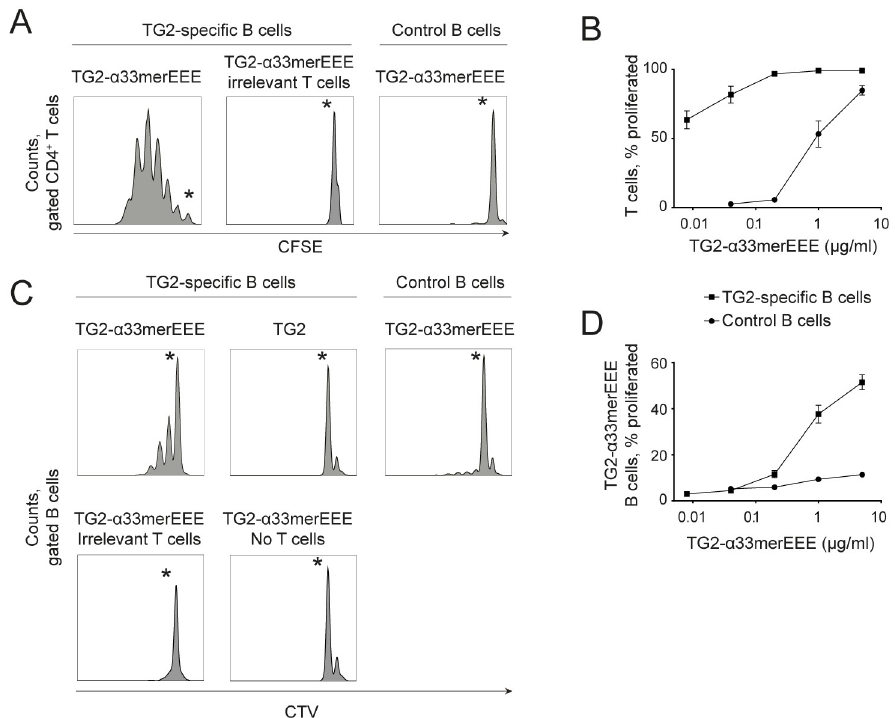
Fig 1. TG2-specific B cells and gluten-specific CD4 + T cells interact in vitro. B cells isolated from Tgm2 -/- DQ2.5.14E06 or HLA-DQ2.5 mice, and CD4 + T cells isolated from DQ2.5.TCR-glia- α 2 or DQ2.5.TCR-glia- ω 2 mice were labeled with different proliferation-tracking dyes and co-cultured in vitro for three days stimulated with indicated antigens. (A) Representative histogram plots gated on CD4 + T cells showing proliferation in response to TG2- α 33merEEE fusion protein at 0,2 μ g/mL. (B) Dose response curve of T-cell proliferation to TG2- α 33merEEE fusion protein. (C) Representative histogram plots gated on B220 + B cells showing proliferation in response to TG2- α 33merEEE fusion or TG2 at 5 μ g/mL. (D) Dose response curve of B-cell proliferation to titrations of TG2- α 33merEEE fusion protein. Asterisk ( � ) indicates the undivided peak. Graphs report proliferation as % proliferated CD4 + T or B220 + B cells. Points and bars represent mean +/- SEM. Data is representative of three independent experiments set in duplicates. CFSE: Cell Trace Carboxyfluorescein Succinimidyl Ester CTV: Cell Trace Violet.